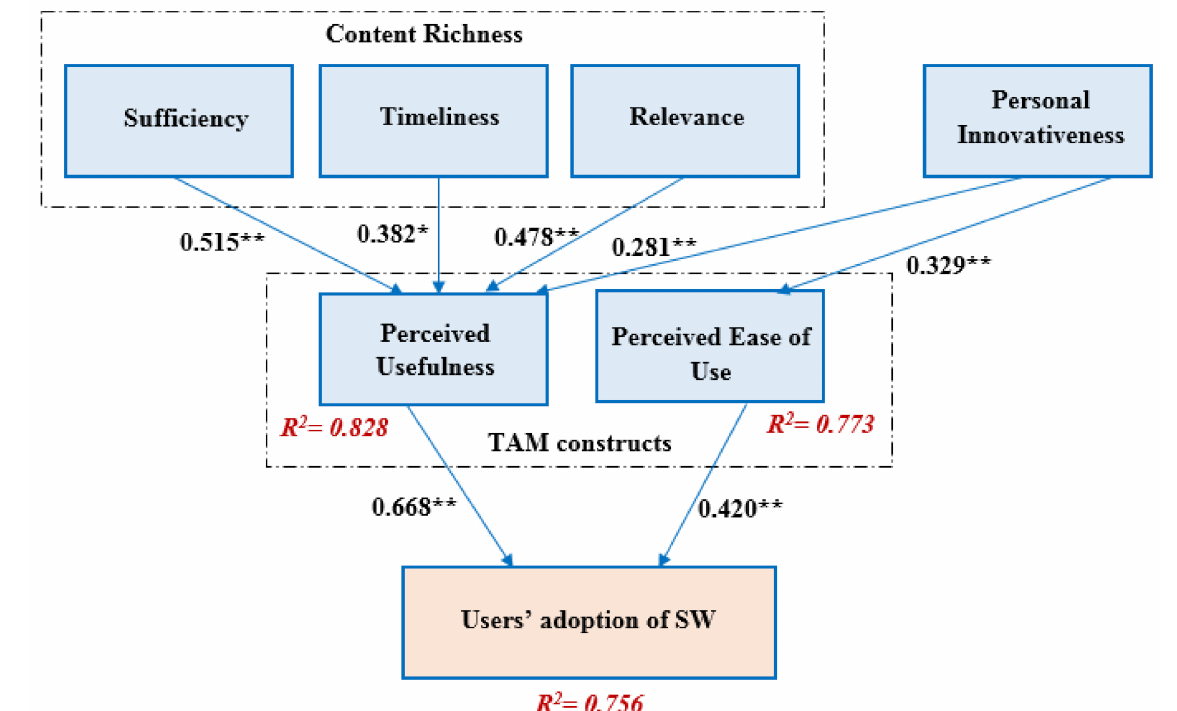
Figure 2. Path coefficient of the model (significant at ** p ≤ 0.01, * p <